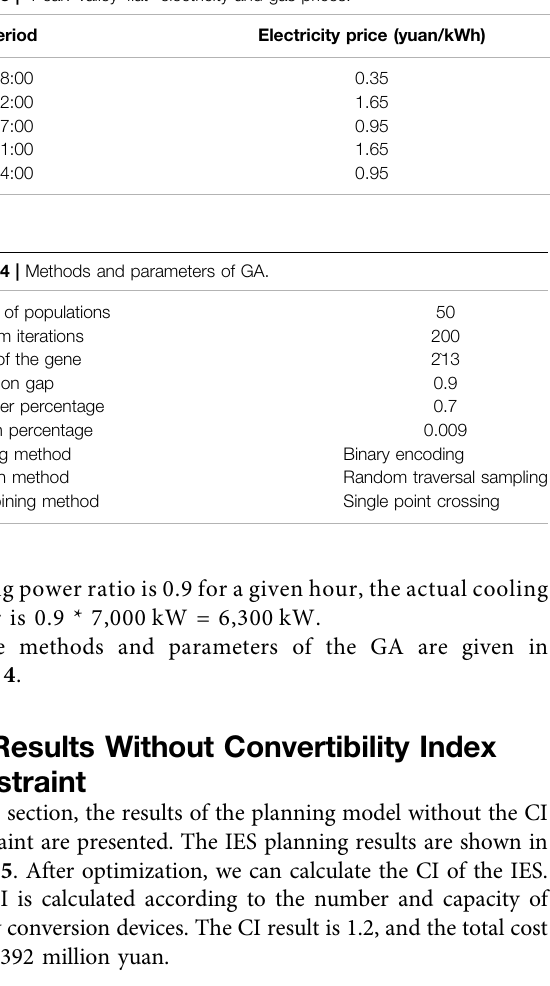
TABLE 3 | “ Peak – valley – fl at ” electricity and gas prices.